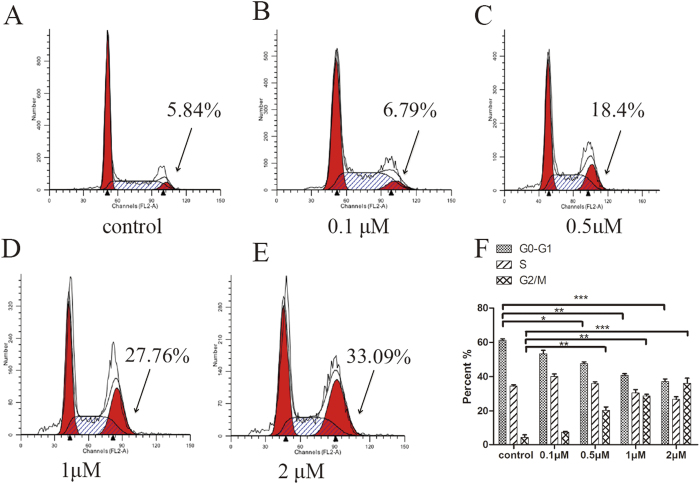
CPUY201112 induces MCF-7 G2/M cell-cycle arrest and apoptosis.(A) Control. (B) 0.1 μM. (C) 0.5 μM. (D) 1 μM. (E) 2 μM. (F) The cell cycle percentages were quantified using Flow Cytometry. *p < 0.05; **p < 0.01. MCF-7 cells were treated with CPUY201112 at the indicated concentrations. Cells were harvested, stained with propidium iodide and analyzed by flow cytometry to determine DNA content.